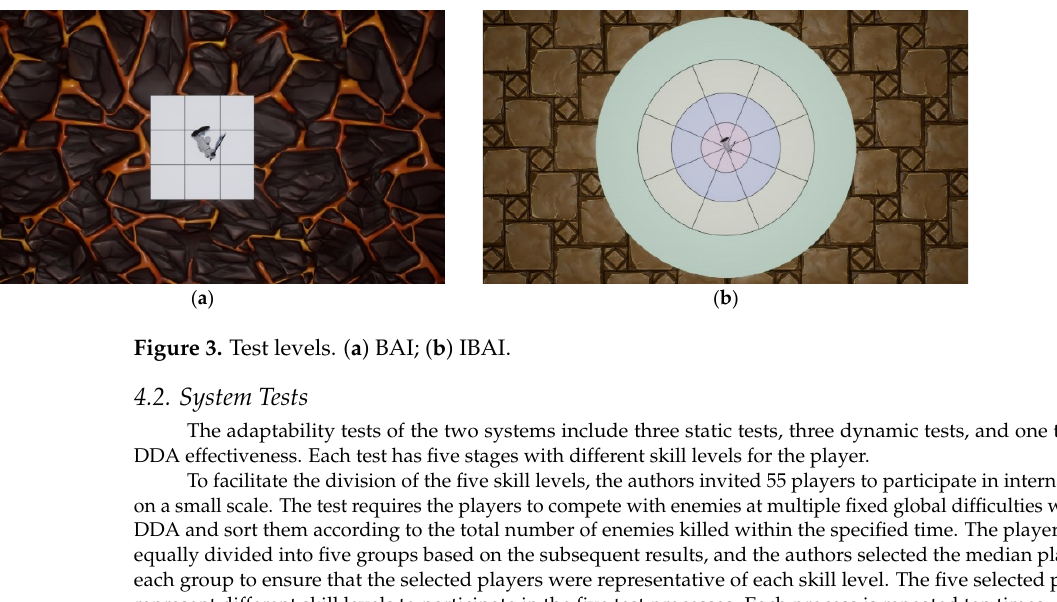
Table 4. Type and number of enemies used in each static test.